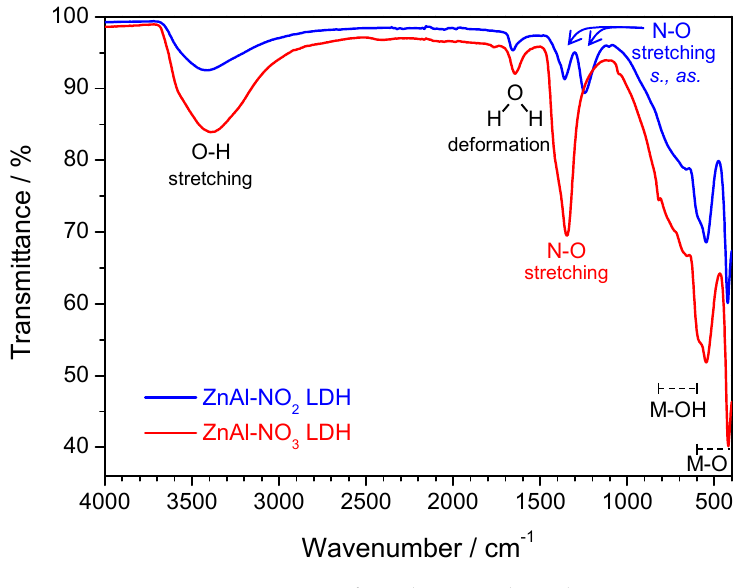
Materials 2020 , 13 , x FOR PEER REVIEW Figure 2. FTIR spectra of ZnAl-NO 3 and ZnAl-NO 2 . Figure 2. FTIR spectra of ZnAl-NO 3 and ZnAl-NO 2 .